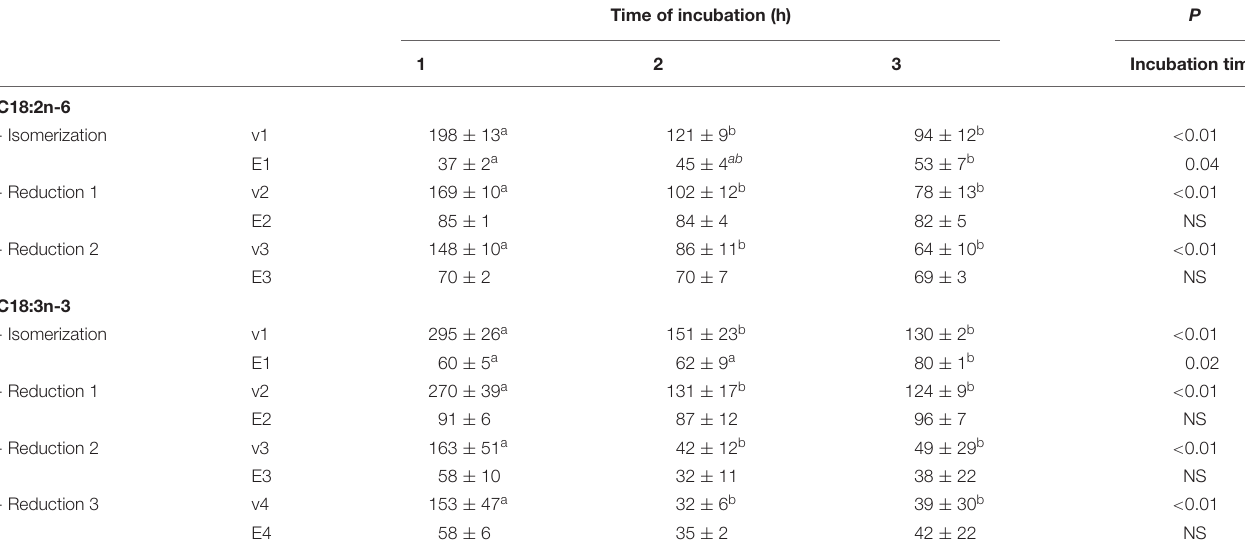
TABLE 1 | Rates (v, mg/L/h) and efficiencies (E, %) of the reactions of BH of 1 mg of C18:2n-6 or C18:3n-3 after 1, 2, and 3 h incubations in an enzymatic solution obtained from cow’s ruminal content (mean ± SD, Experiments 1.1 and 2.1). Time of incubation (h) P 2 3